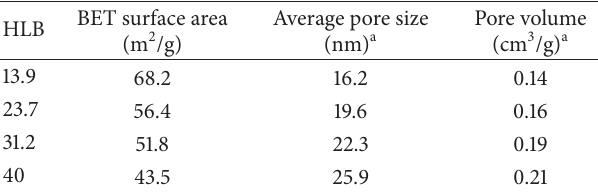
Table 2: Textural properties of prepared